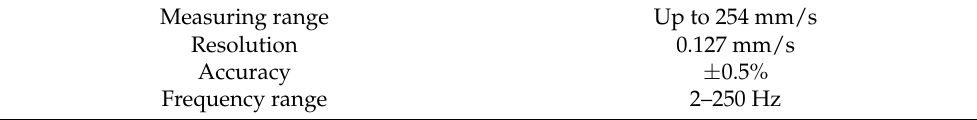
Table 1. Characteristics of the Instantel Minimate Plus measuring equipment.